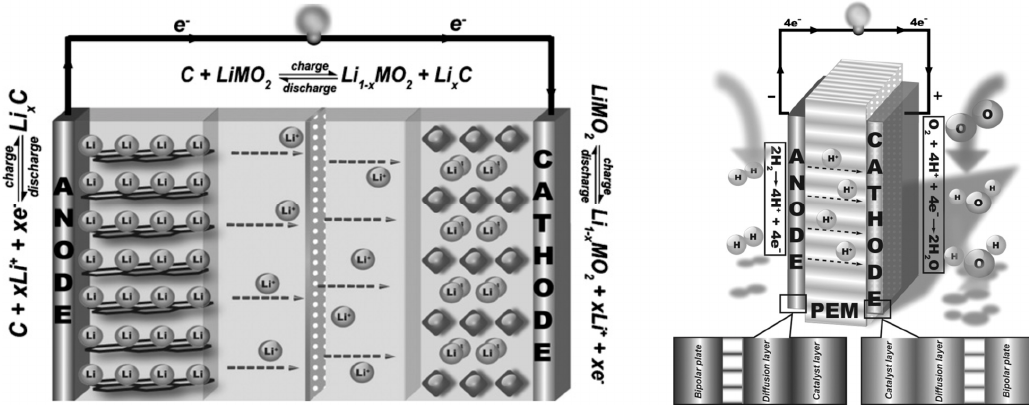
Figure 29. Schematic representations of a rechargeable lithium ion (Li-ion) battery ( left ) and a proton exchange membrane fuel cell ( right ). Adapted with permission from ref [123]. Copyright 2009, Elsevier Inc.